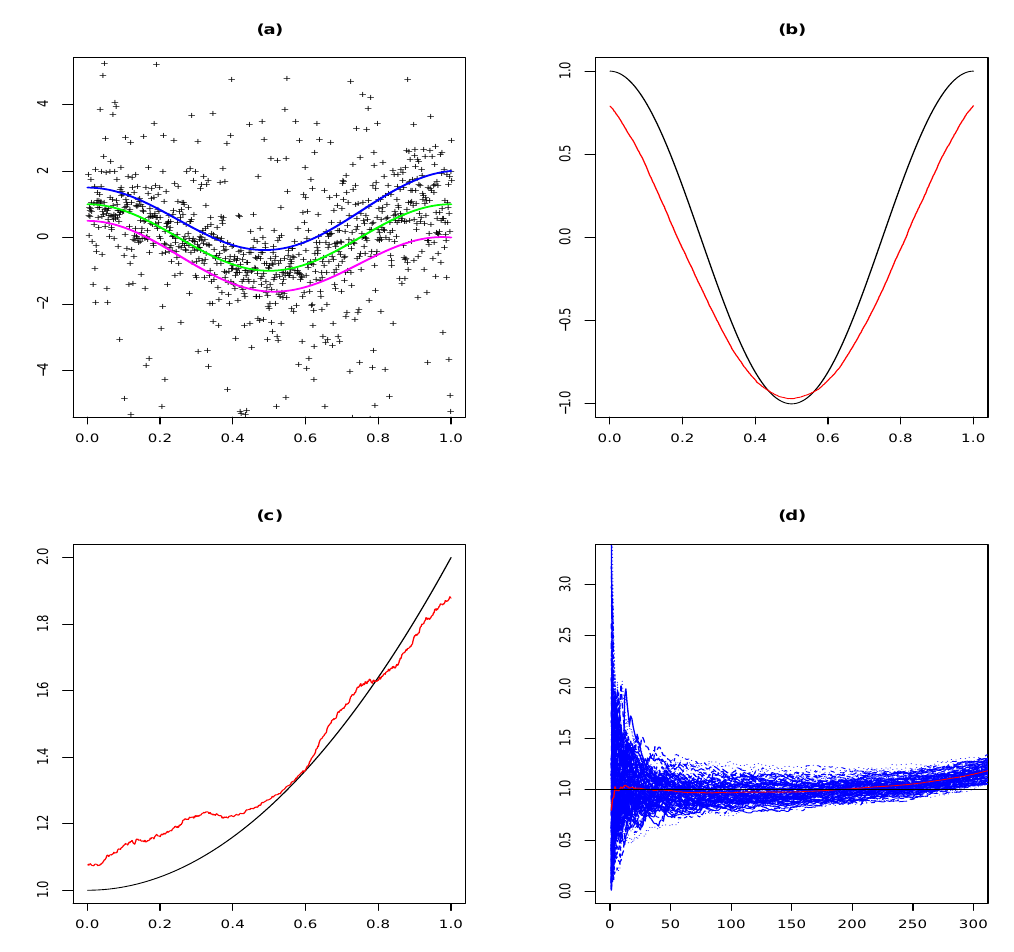
Figure 1: Student distribution with ν = 1 df. (a): Simulated data ( + ) and conditional quantiles q (3/4 | ·) (magenta), q (1/2 | ·) (green) and q (1/4 | ·) (blue). (b): Location function a (·) (black) and mean estimate ¯ˆ a ¯ˆ mean estimate b n (·) (red). (d): Conditional tail-index γ (black), estimates ˆ γ n , i , i = 1, . . . , N (blue) and mean estimate ¯ˆ γ n (red) as functions of k 1, . . . , 300 } n ∈ {